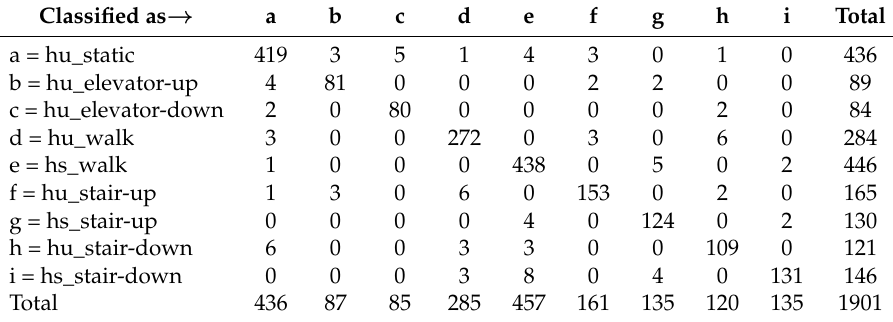
Table 10. Confusion matrix of multi-floor motion recognition using improved RF with